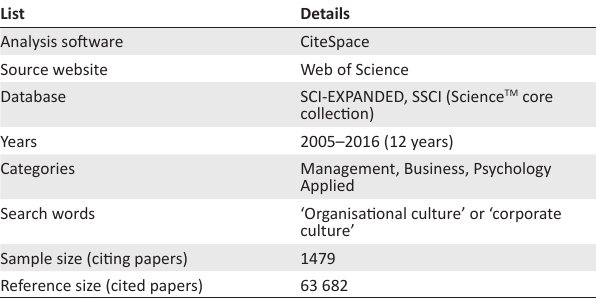
TABLE 1: Summary of search